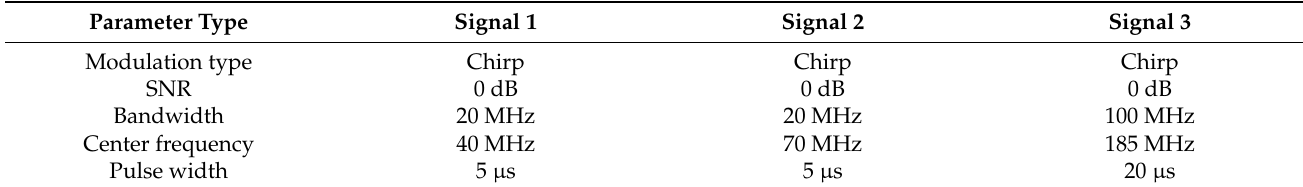
Table 3. Input signal parameters.